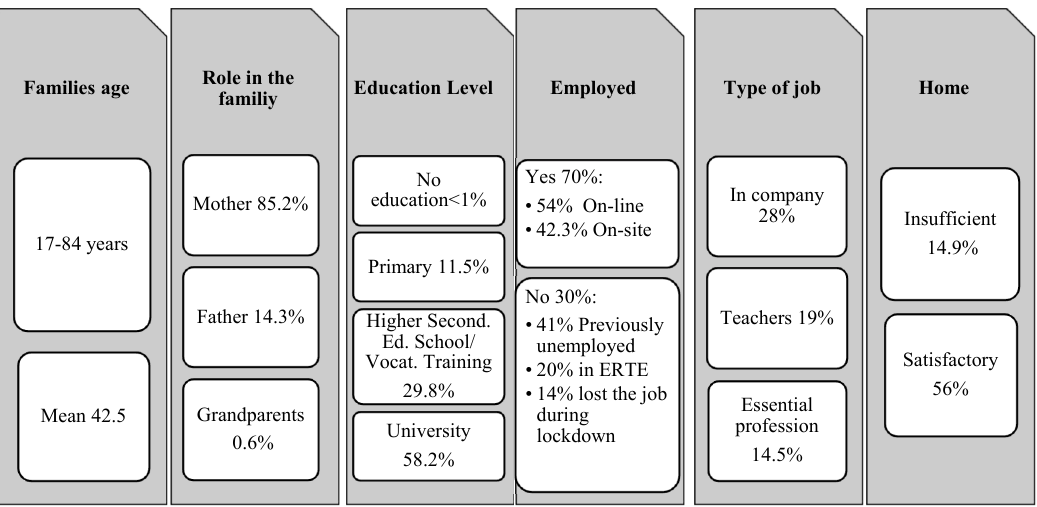
Figure 1. Basic characteristics of the families surveyed in the Valencian Community (Spain).